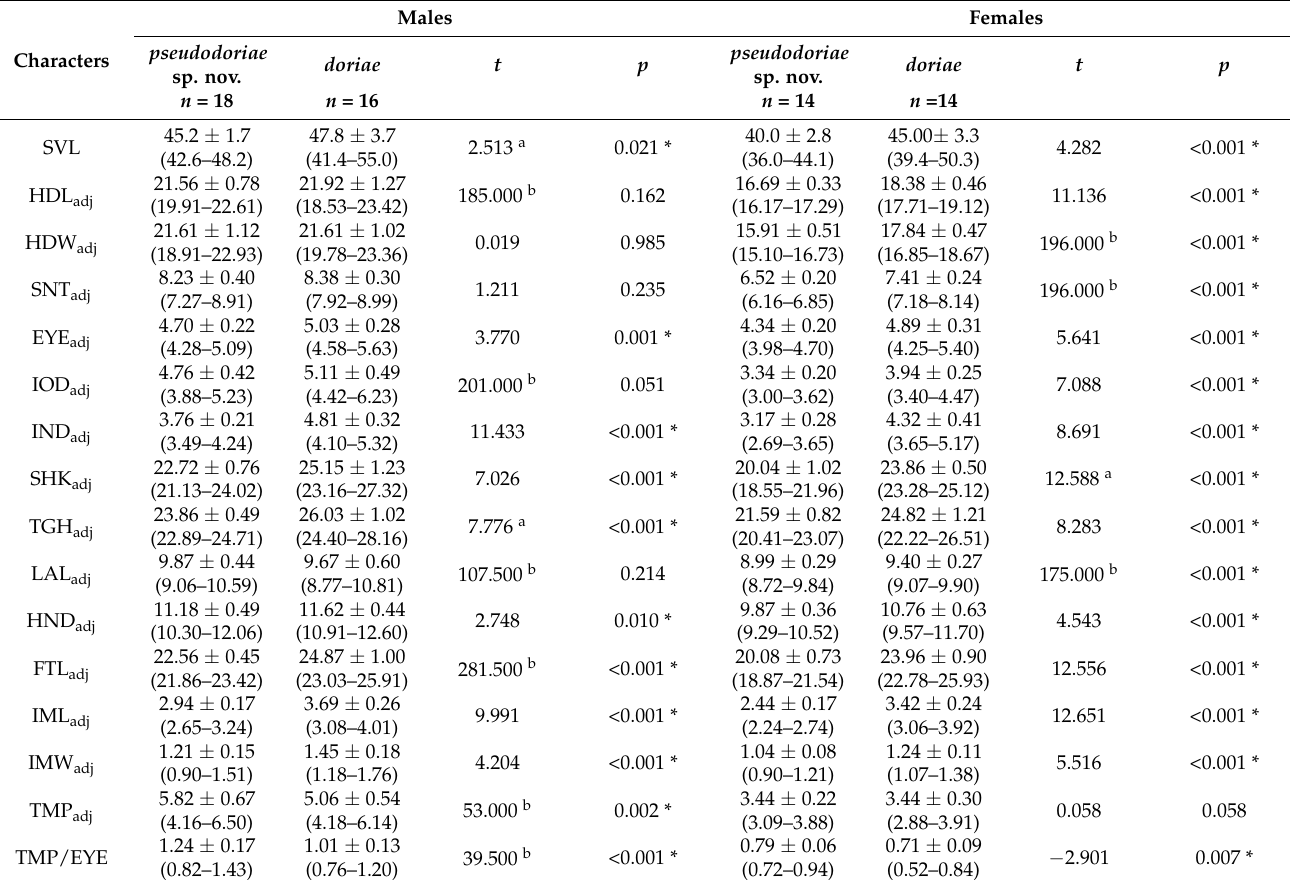
Tables S2 and S3. Table 4. Statistical comparisons of males and females of Limnonectes pseudodoriae sp. nov . and L. doriae . Males Females pseudodoriae Characters doriae sp. nov.